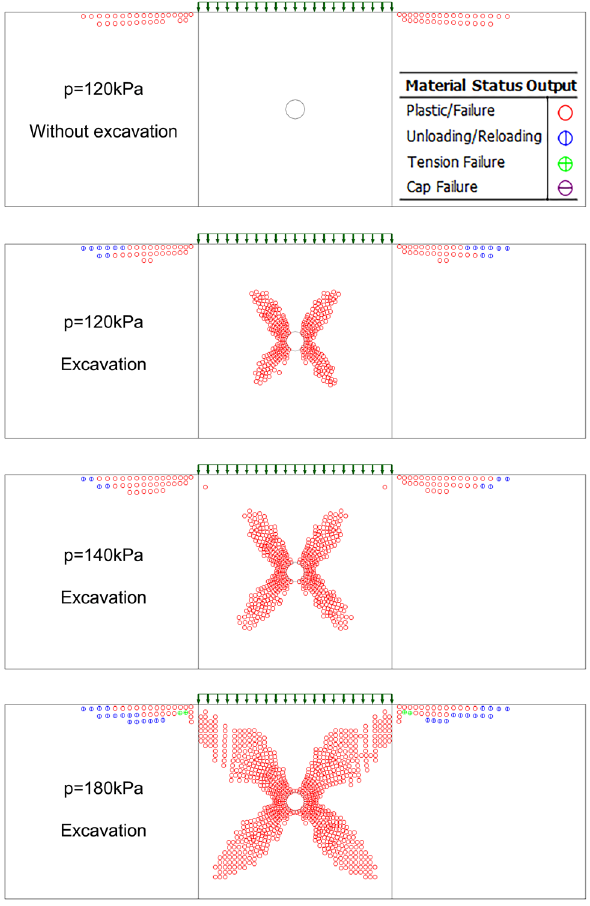
Fig. 5 Evolution of the plastic zone with the increase of surcharge